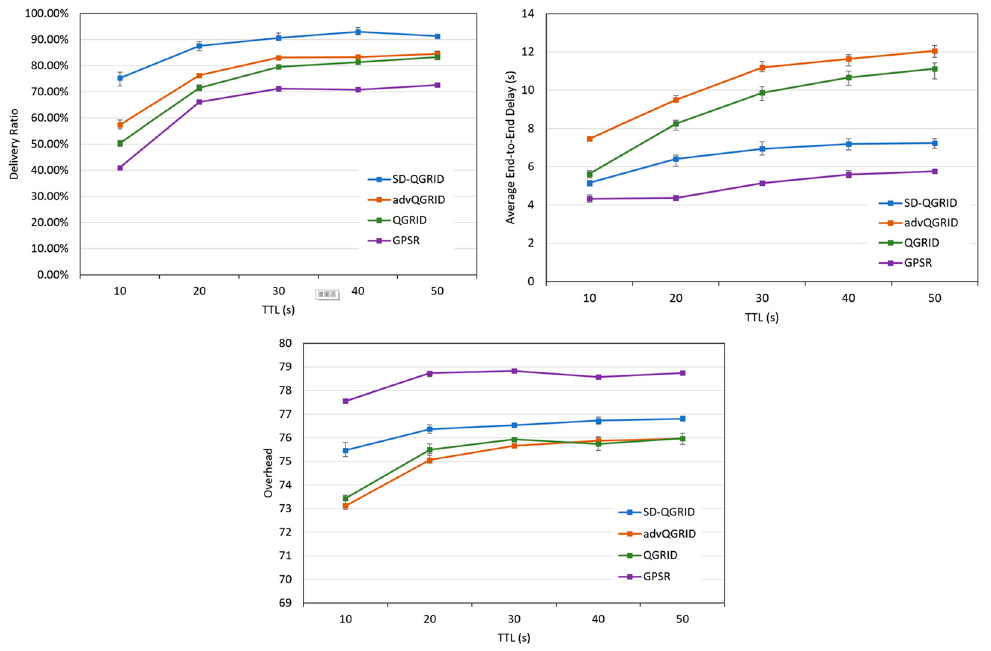
Figure 15. Simulation comparison among different routing protocols vs. different TTLs. Table 10. Performance improvement of SD-QGrid compared to routing protocols with TTLs.